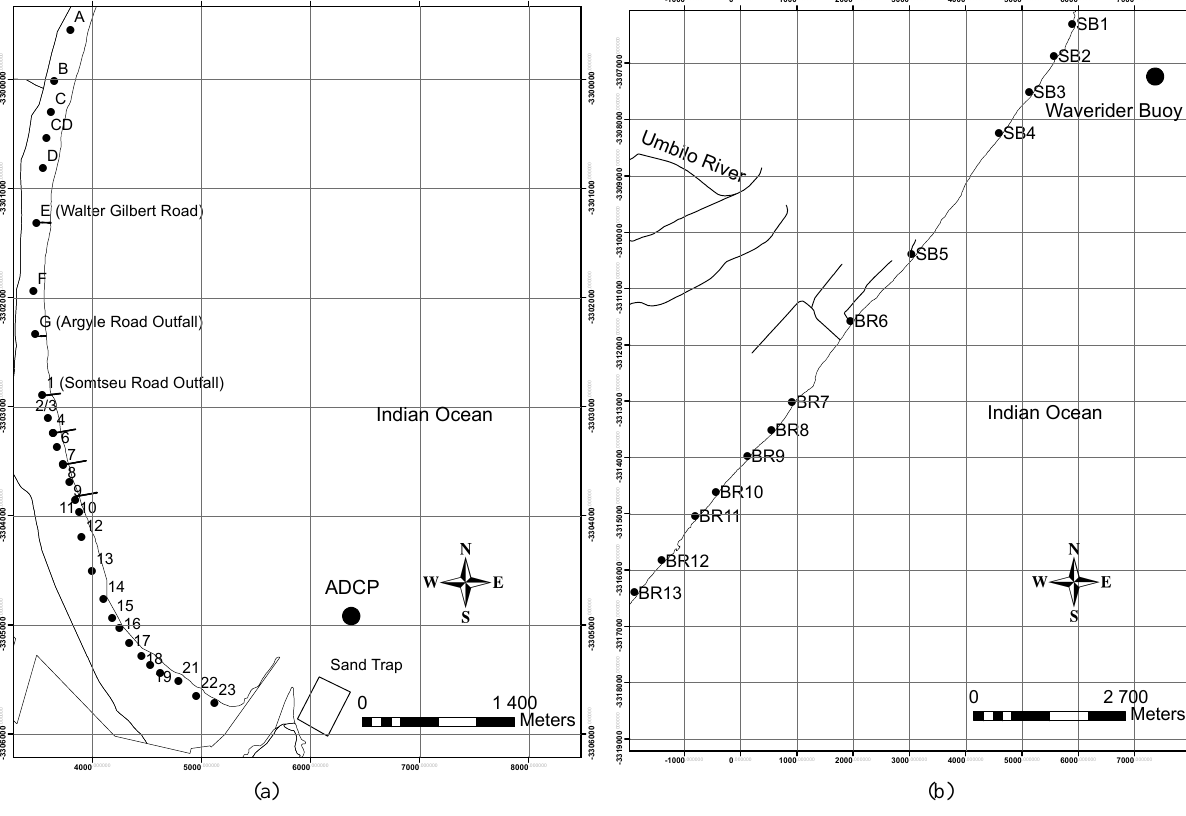
Fig. 3. Locations of beach profiles and wave recording instruments. Coordinate system: Lo 31 WGS84. (a) Profiles A to 23 of the Durban Bight and the Durban Waverider Buoy (b) Profiles BR6 to BR10 of the Durban Bluff Beaches and the Durban ADCP. Table 1. Historical wave recording instruments, their operating pe- riods and water depth.